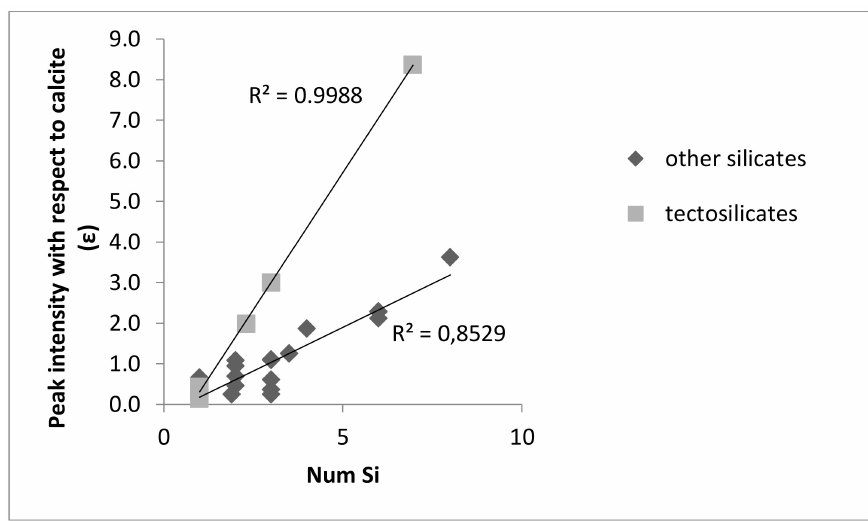
Figure 1. Main peak intensity in the IR range of 600–4000 cm − 1 with respect to the calcite main peak for several silicates as a function of the number of Si atoms in the formula.